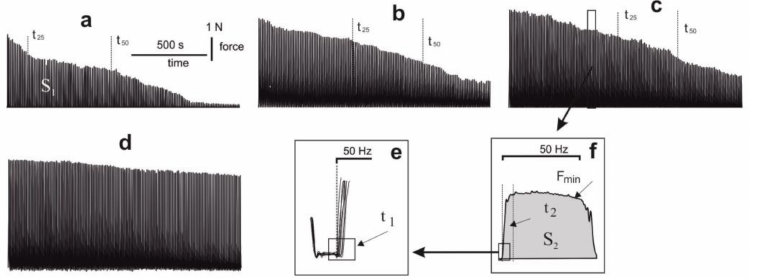
Figure 2. Curves of the generation of the contraction force of muscle soleus rat after chronic intoxica- tion with glyphosate for 30 days: ( a ), ( b ), ( c ) and ( d )—the curves of muscle contraction for 1500 s with the administration to the animals of glyphosate, glyphosate and C 60 FAS at doses of 0.5 and 1 mg/kg, respectively, and with the administration to the animals of distilled water (control group);